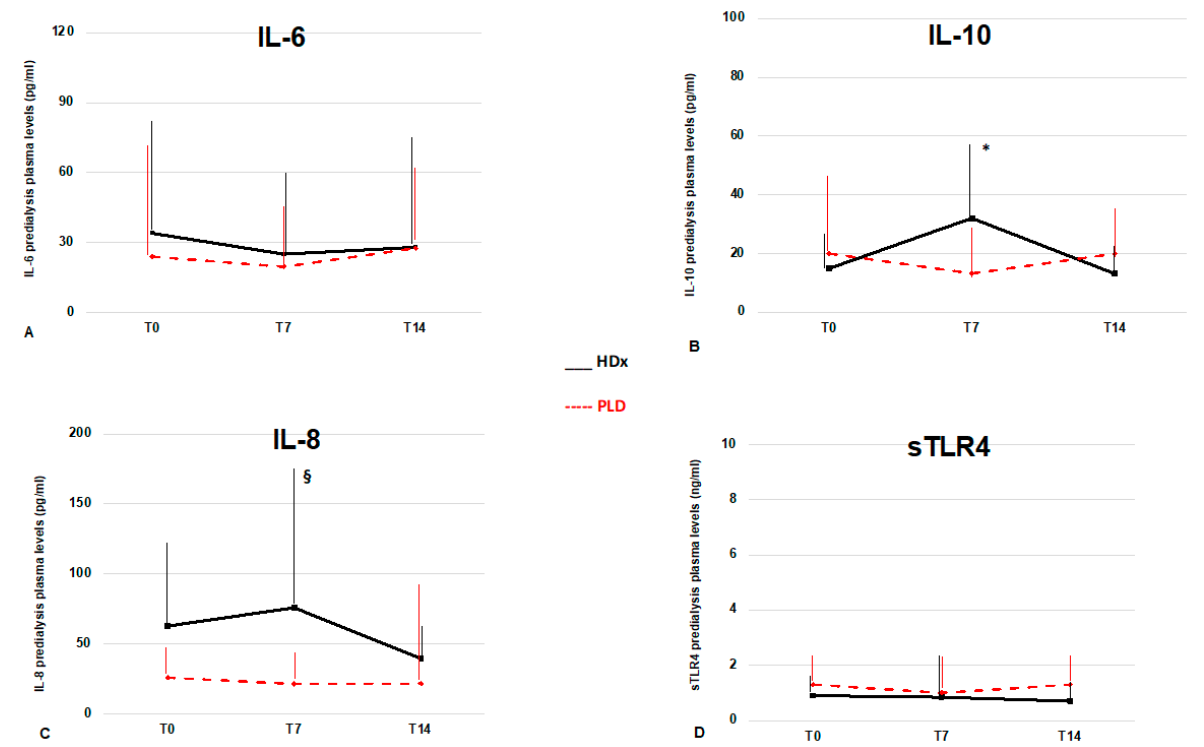
Figure 1. Time trends of pro- and anti-inflammatory cytokines in maintenance HD patients with COVID-19. ( A ) IL-6 did not show significant longitudinal changes during the observation interval. ( B ) IL-10 showed a significant increase in the first week after the diagnosis of COVID-19 in the HDx group. ( C ) IL-8 levels did not show significant intra-group changes, but were higher in patients undergoing HDx at T7. ( D ) sTLR4 levels did not show significant modifications during the study. Black lines for expanded hemodialysis (HDx) and red lines for protein-leaking dialysis (PLD). * = p < 0.05 vs. T0; § = p < 0.05 vs. PLD.